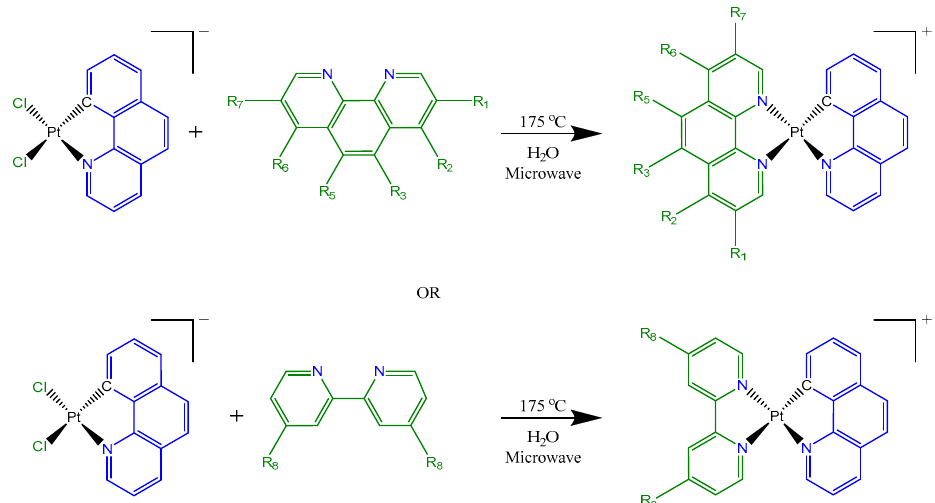
Scheme 1. Synthesis of polyaromatic cyclometallated complexes (CMC): 1 if R 8 =